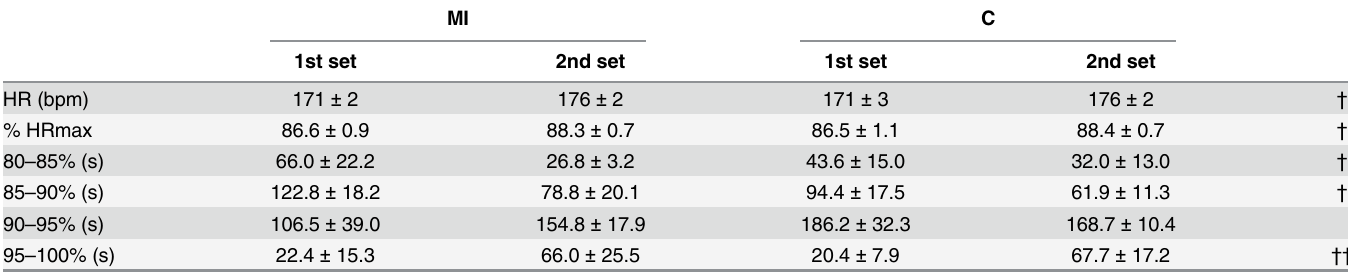
Table 1. Mean ( ± standard error) heart rate (HR), percentage of maximal HR (%HRmax), and time (s) spent in the five zones of HRmax for the first and second sets of training session including motor imagery (MI) and control (C) training sessions.